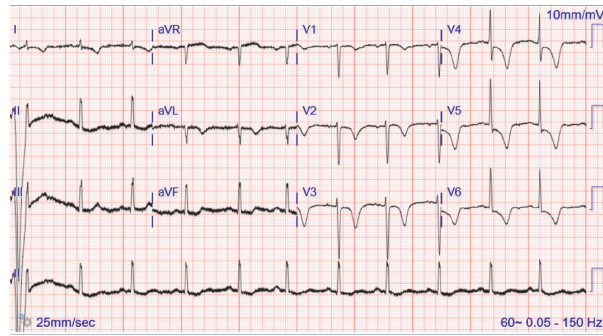
Figure 3: ECG during second SC episode with deep symmetrical T inversions in leads V1–V6.